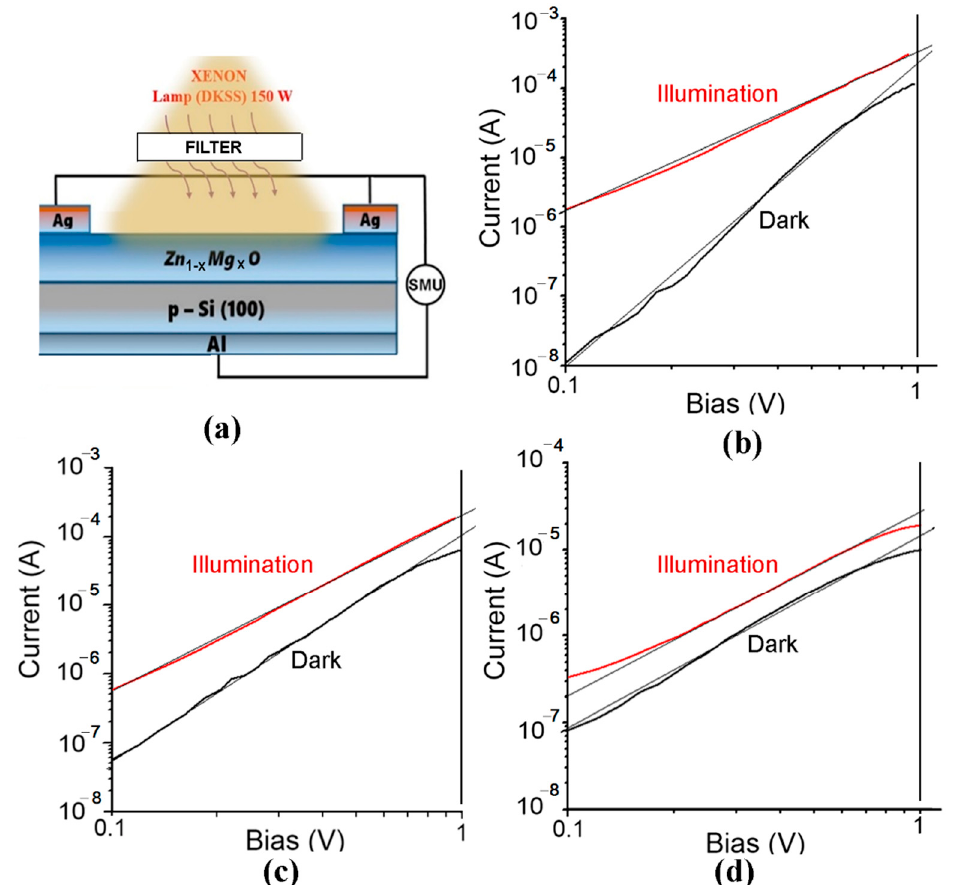
Figure 11. Design of n-Zn 1 − x Mg x O/p-Si heterostructure photodiodes ( a ) and current–voltage charac- teristics of devices, fabricated on films deposited by spin coating, plotted for forward bias in a double logarithmic scale for x values in films of 0.1 ( b ), 0.2 ( c ), and 0.4 ( d ).